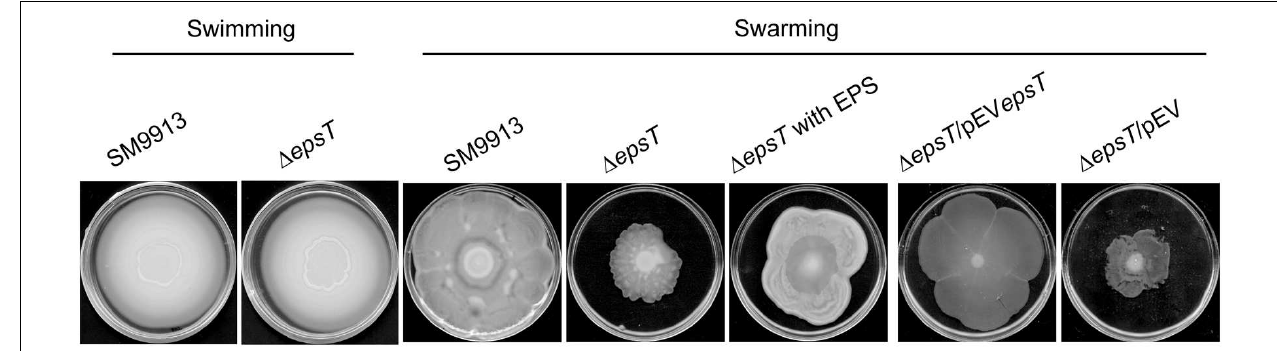
FIGURE 2 | The swimming and swarming motilities of wild SM9913, (cid:49) epsT , (cid:49) epsT /pEV epsT, and (cid:49) epsT /pEV. For swimming assay, cultures of strains were inoculated onto the centers of plates containing 0.3% agar and the inoculated plates were incubated at 15 ◦ C for 3 days. For swarming assay, cultures of strains were inoculated onto the centers of plates containing or 0.5% agar and the inoculated plates were incubated at 15 ◦ C for 5 days. For the assay of (cid:49) epsT with exopolysaccharide (EPS), 5 µ l of EPS (2 mg/ml) were dropped onto the center of the plate before inoculation. Pictures are a representative of three independent experiments.